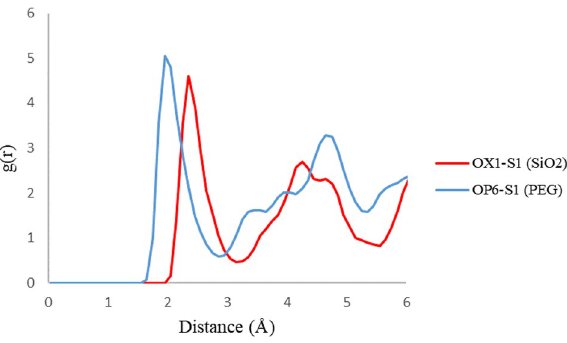
Figure 9. RDF plots for S1 atom of 3TC relative to the adsorption sites of SiO 2 (red) and PEG (blue).